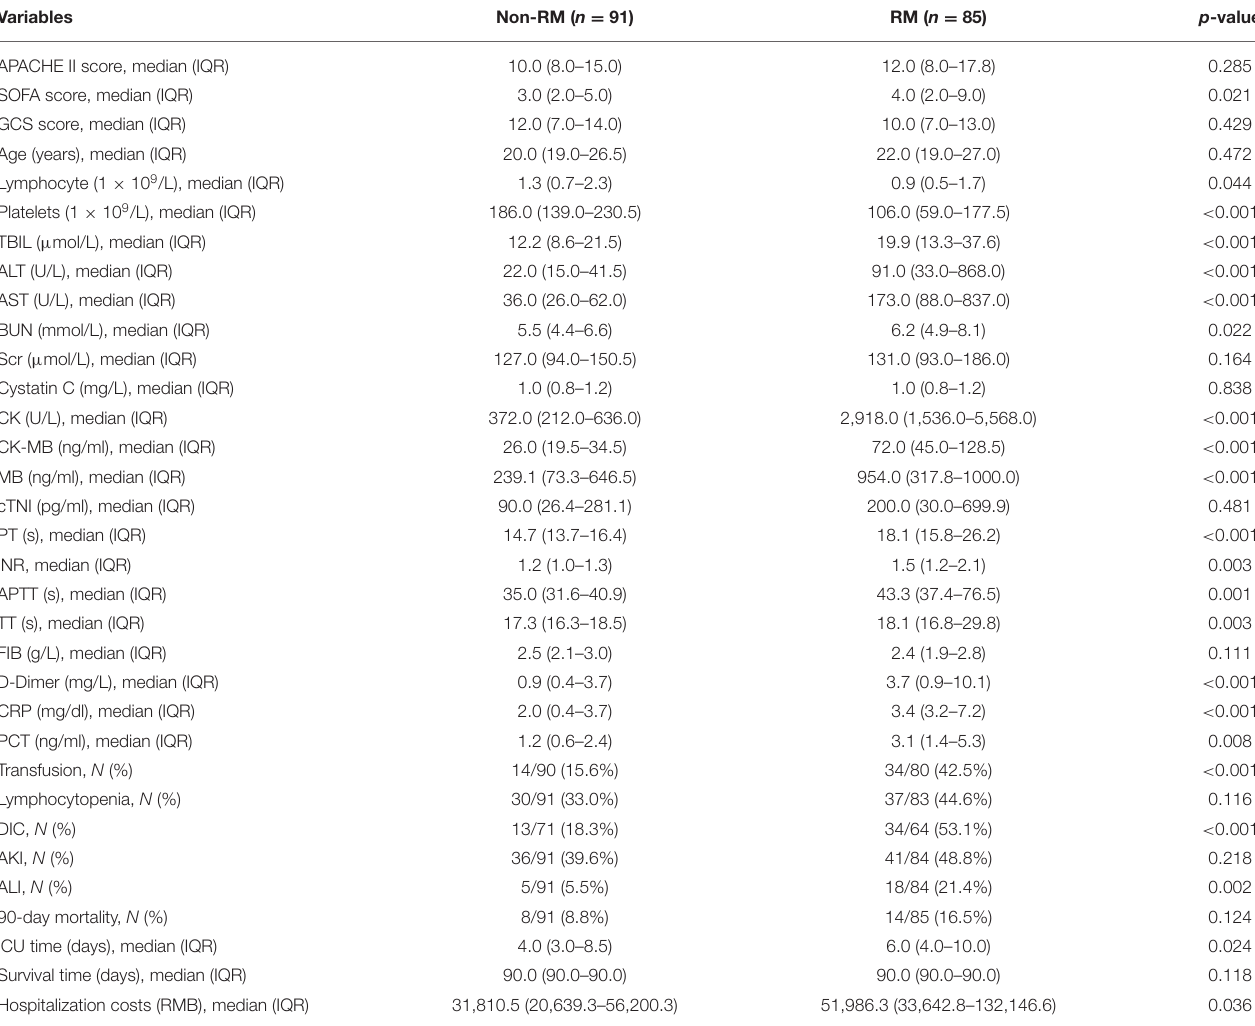
TABLE 1 | Comparisons of clinical characteristics between patients with rhabdomyolysis (RM) and non-RM with exertional heat stroke (EHS). Variables